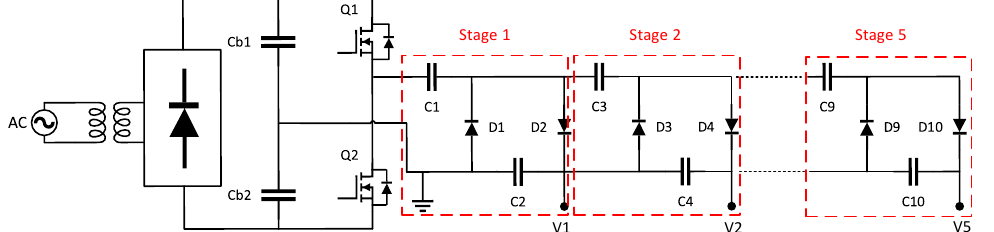
Figure 5. Final AC/DC converter topology with all conversion stages.